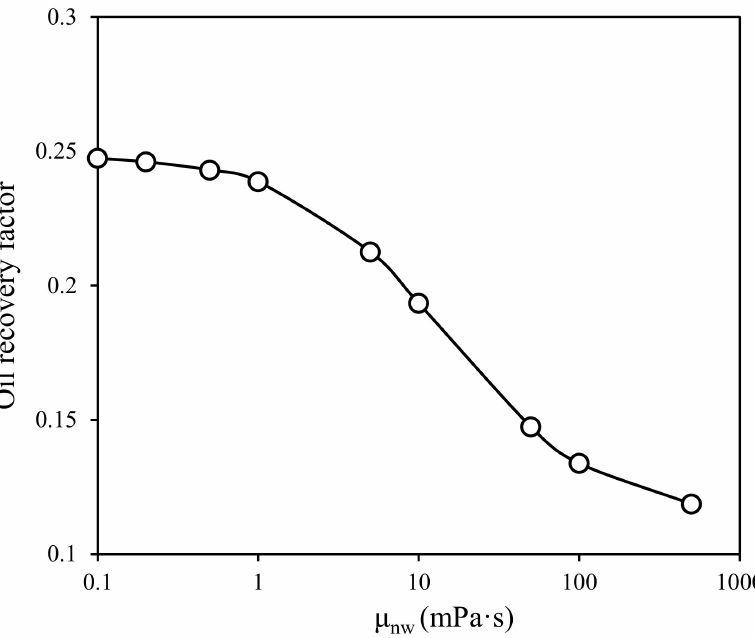
Figure 7. Oil recovery factor of different non-wetting phase viscosities of three interacting capillaries.